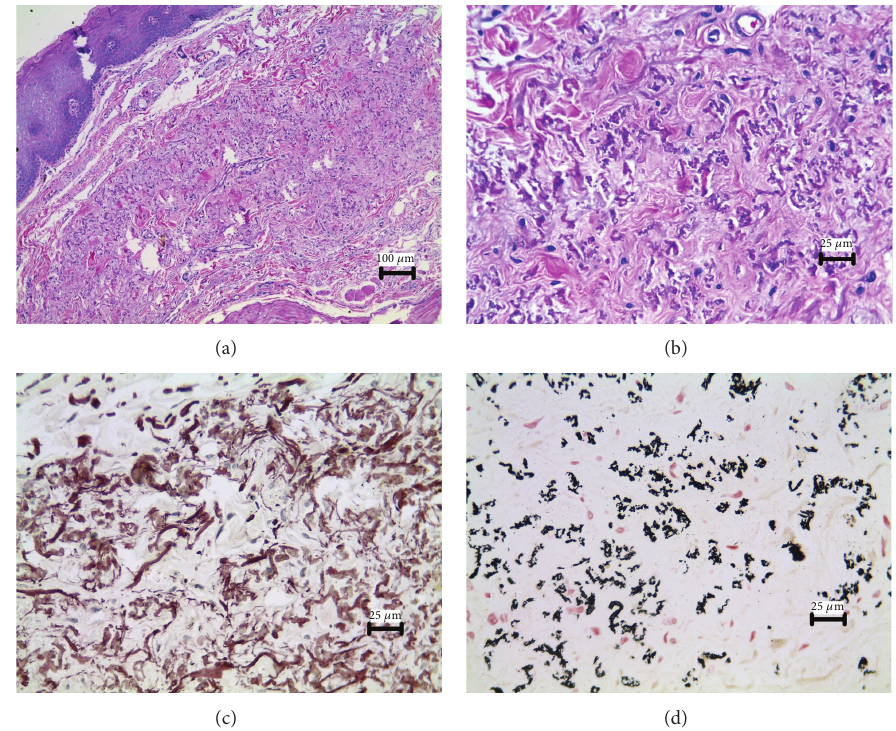
Figure 2: Histopathological aspects of the lesion. (a) Presence of a noncapsulated lesion in the connective tissue (H&E, original magnification × 100). (b) An aggregation of fragmented and basophilic fibers dispersed along with collagen fibers (H&E, original magnification × 400). (c) Orcein staining showing an increased amount of fragmented elastic fibers (original magnification × 400). (d) Von Kossa staining confirming the presence of calcium deposits inside the lesion (original magnification × 400).